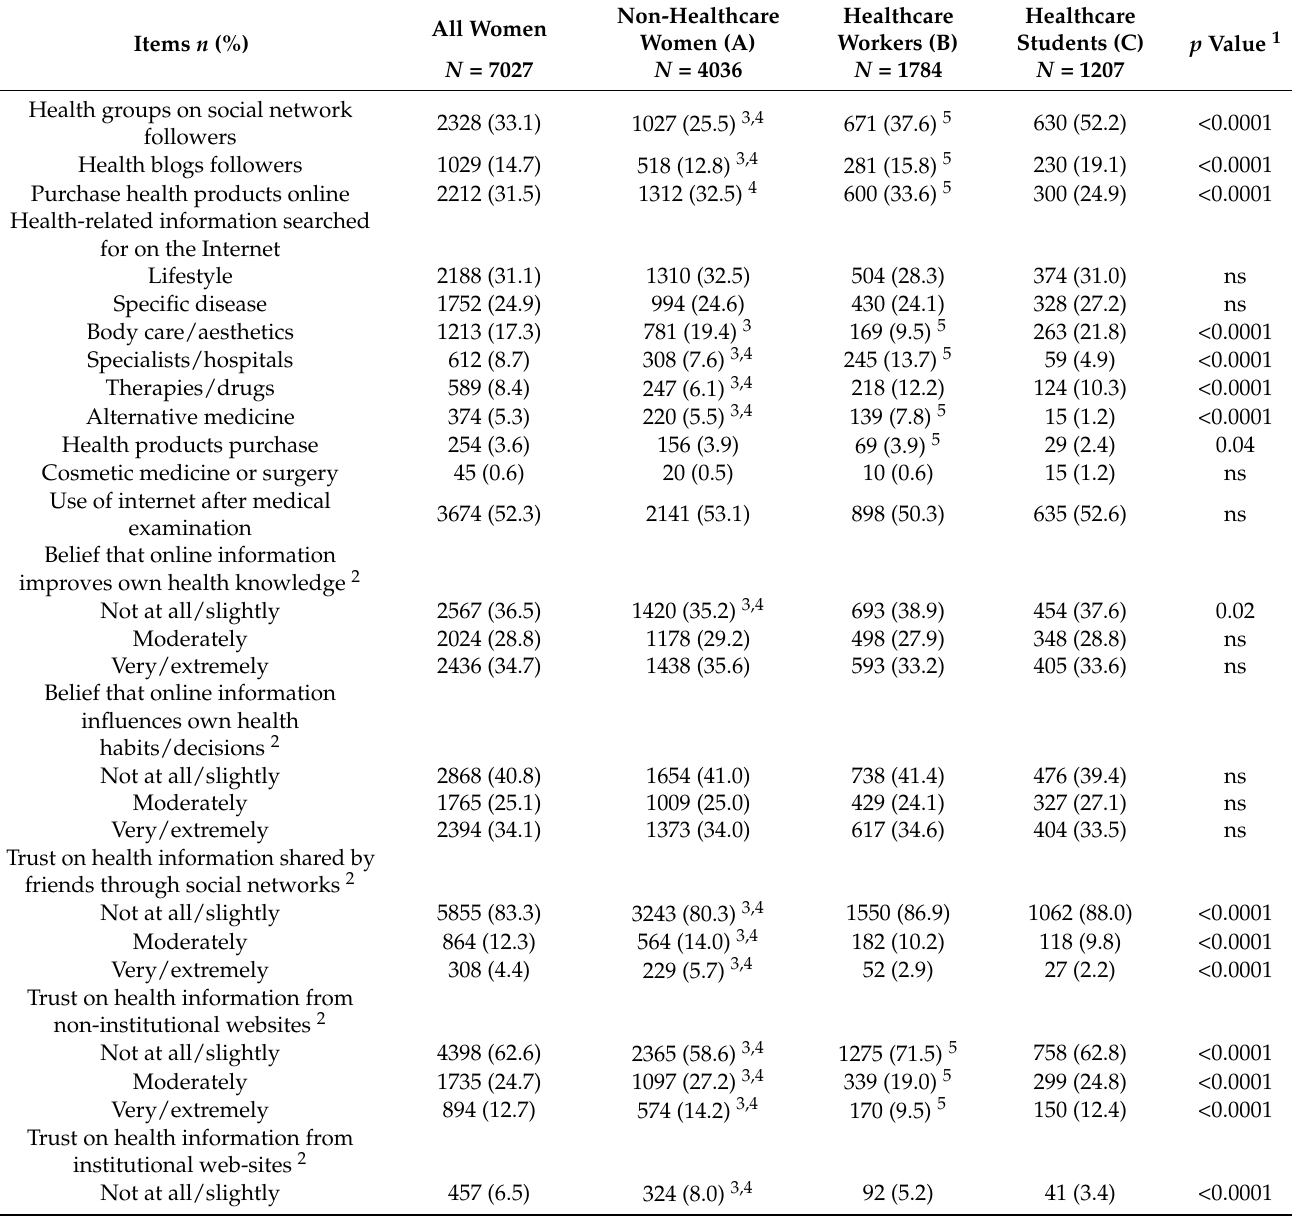
Table 2. Online health information-seeking behavior and perceptions in non-healthcare vs. healthcare